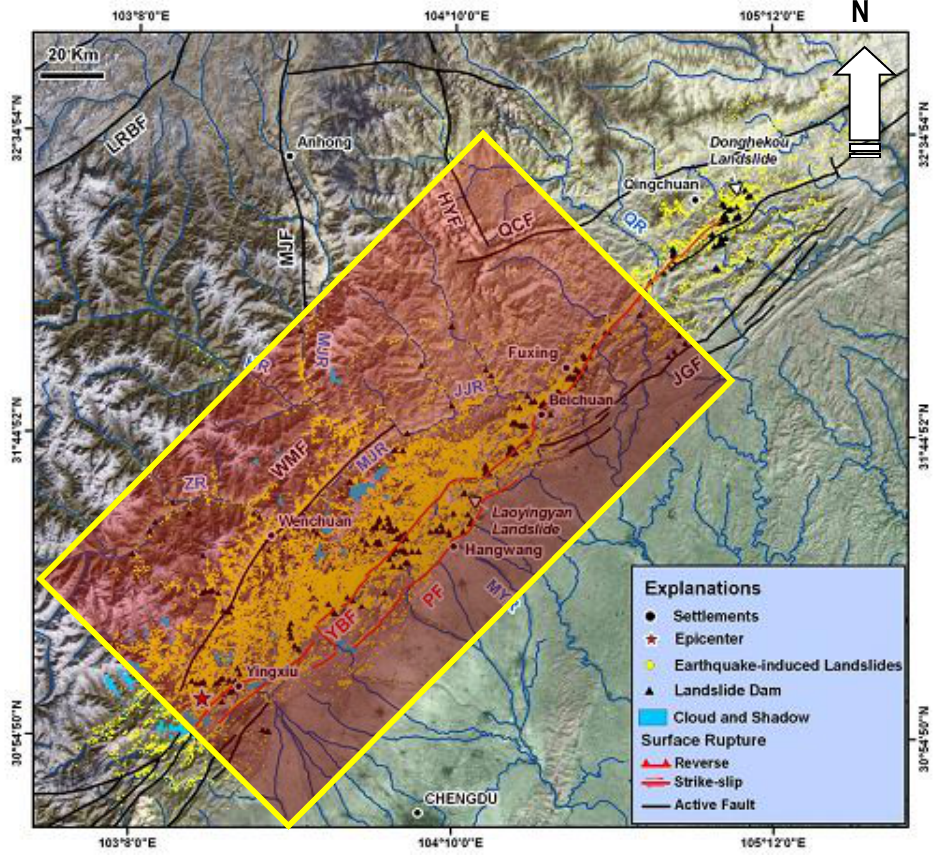
Figure 1. Location and 12 May 2008 Wenchuan earthquake fault surface rupture